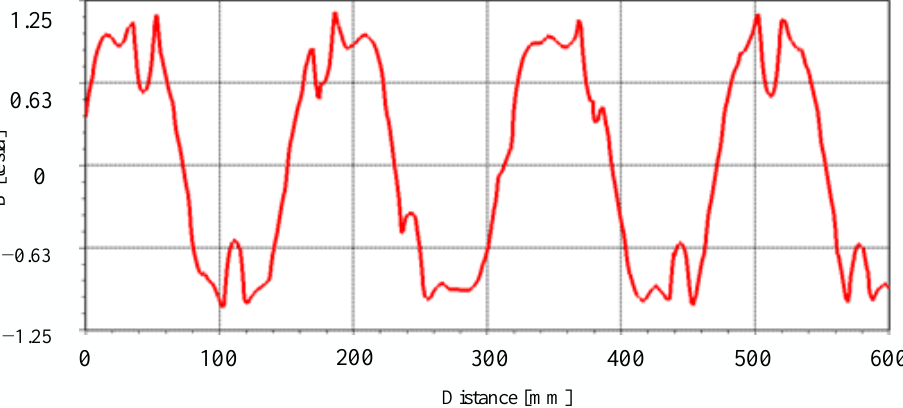
Figure 5. Flux density without optimization.